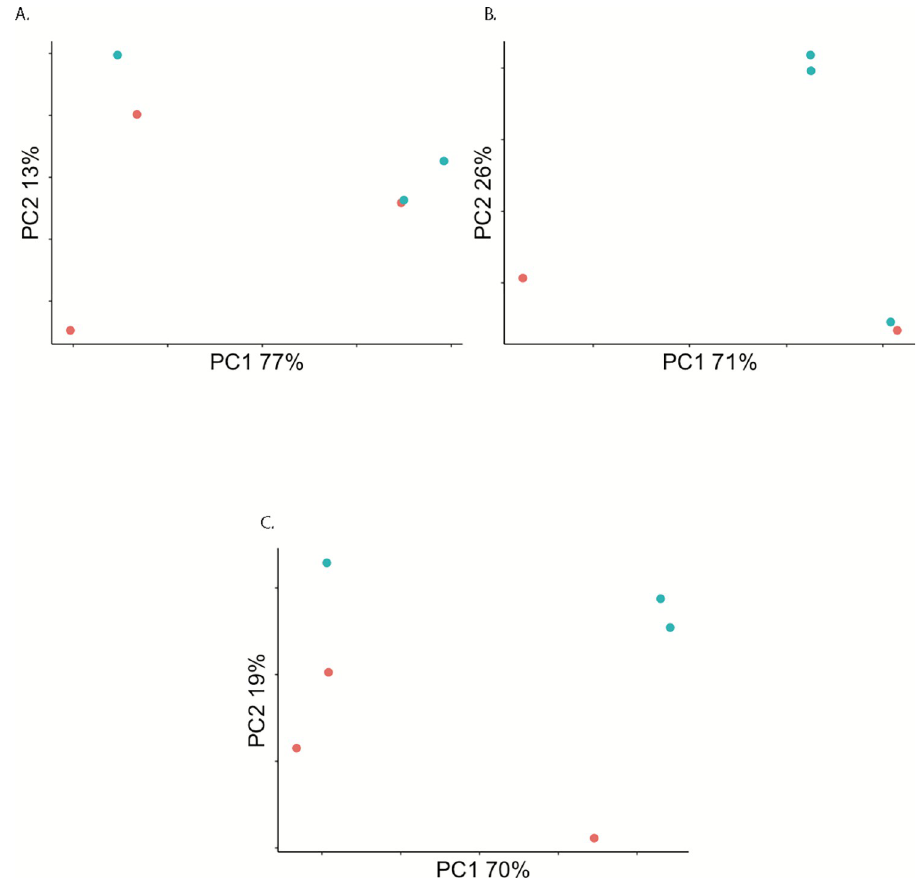
Fig 6. Principal Components Analysis (PCA) on read counts mapping to miRNAs identified in the AsteI2 build of the An . stephensi genome in Vectorbase. A.—C. are the 2 dpi, 7 dpi, and 14 dpi groupings respectively. In all PCAs, blue is Mayaro infected, and red is